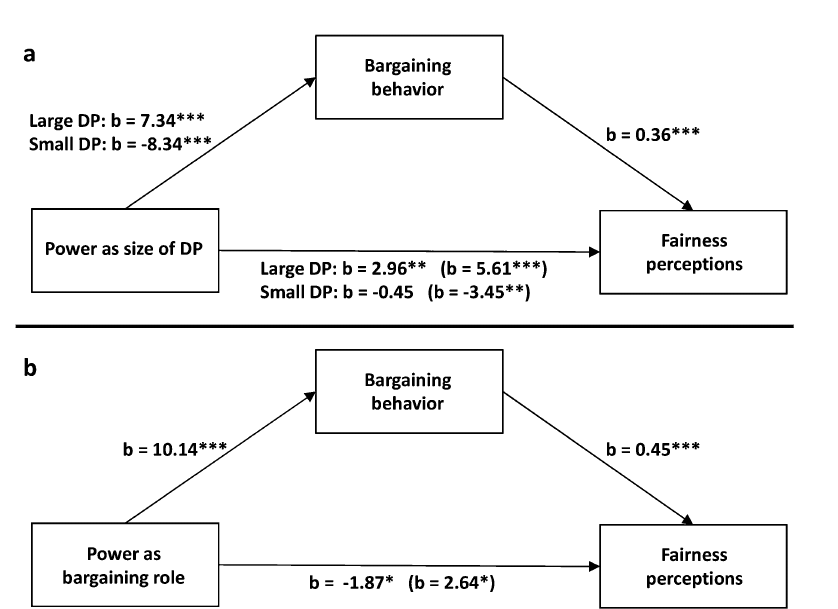
Figure 2. Simple mediation analyses. Regression coefficients for the relationship between the size of DP ( a ) or bargaining role ( b ) and fairness perceptions as mediated by bargaining behavior. The effects of the size of DP and bargaining role on fairness perceptions controlling for bargaining behavior are in parentheses. Significant relationships between variables are represented by asterisks: *** p < 0.001, ** p < 0.01, * p <